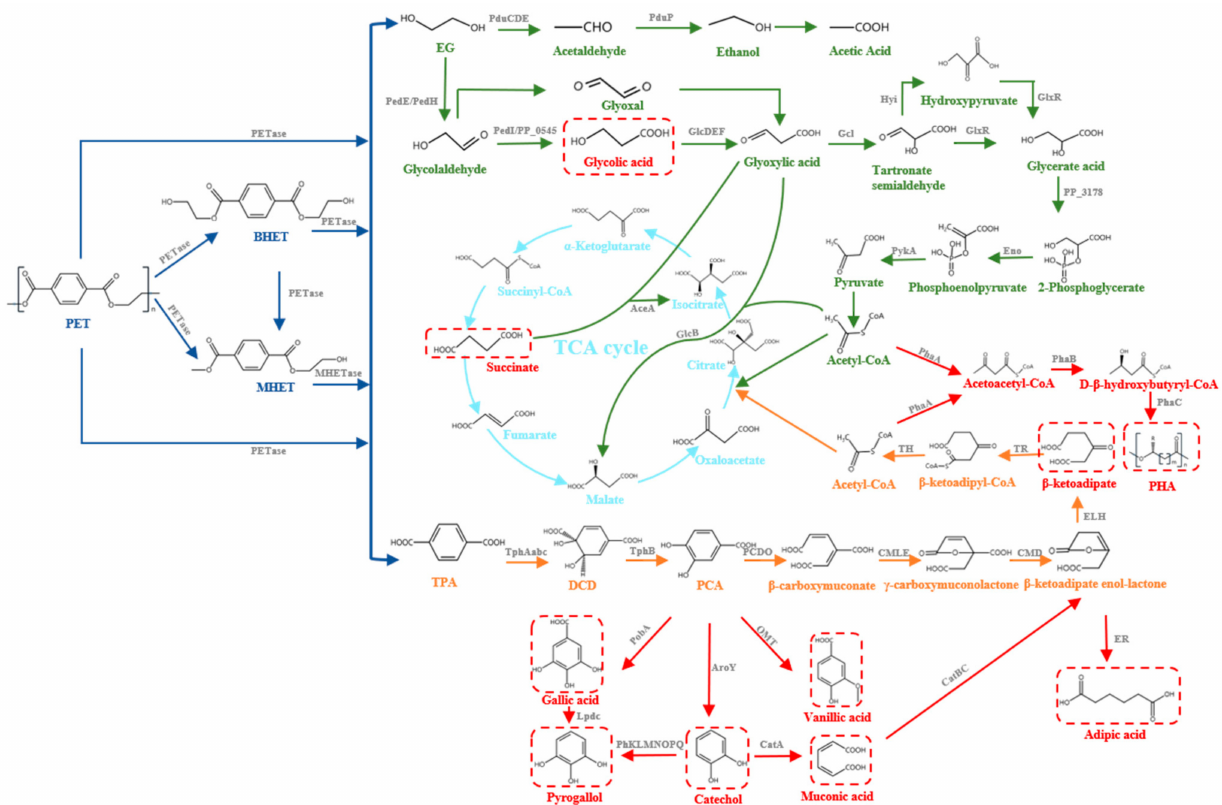
Figure 1. PET metabolic pathways and conversion of high value chemicals. Enzymes im- plicated in the pathways, PedH: quinoprotein alcohol dehydrogenase; PedE: quinoprotein al- cohol dehydrogenase; PedI: aldehyde dehydrogenase family protein; PP_0545: aldehyde de- hydrogenase family protein; GlcDEF: glycolate oxidase; Gcl: glyoxylate carboligase; GlxR: tartronate semialdehyde reductase; PP_3178: glycerate kinase; Eno: Enolase; PykA: Pyruvate ki- nase; GlcB: malate synthase; AceA: isocitrate lyase; Hyi: Hydroxypyruvate isomerase; PduCDE: propane diol dehydratase; PduP: CoA-dependent propionaldehyde dehydrogenase; TphAabc: TPA 1,2-dioxygenase; TphB: 1,2-dihydroxy-3,5-cyclohexadiene-1,4-dicarboxylate dehydrogenase; PCDO: protocatechuate 3,4-dioxygenase; CMLE: β -carboxy-cis, cis-muconate lactonizing enzyme; CMD: β -carboxymuconolactone decarboxylase; ELH: enollactone hydrolase; TR: β -ketoadipate:succinyl- CoA transferase; TH: β -ketoadipyl-CoA thiolase; PhaA: acetyl-CoA acetyltransferase; PhaB: acetoacetyl-CoA reductase; PhaC: poly(3-hydroxyalkanoate) polymerase; PobA: p-hydroxybenzoate hydroxylase; AroY: PCA decarboxylase; OMT: catechol O-methyltransferase; PhKLMNOPQ: phenol hydroxylase; CatA: a catechol 1,2-dioxygenase originating; CatBC: Muconate cycloisomerase 1/Mu- conolactone Delta-isomerase; ER: Enoate reductase. Steps in PET degradation; EG metabolism, TPA metabolism, TCA cycle, and high value chemical synthesis are indicated by dark blue, green, orange, light blue, and red,